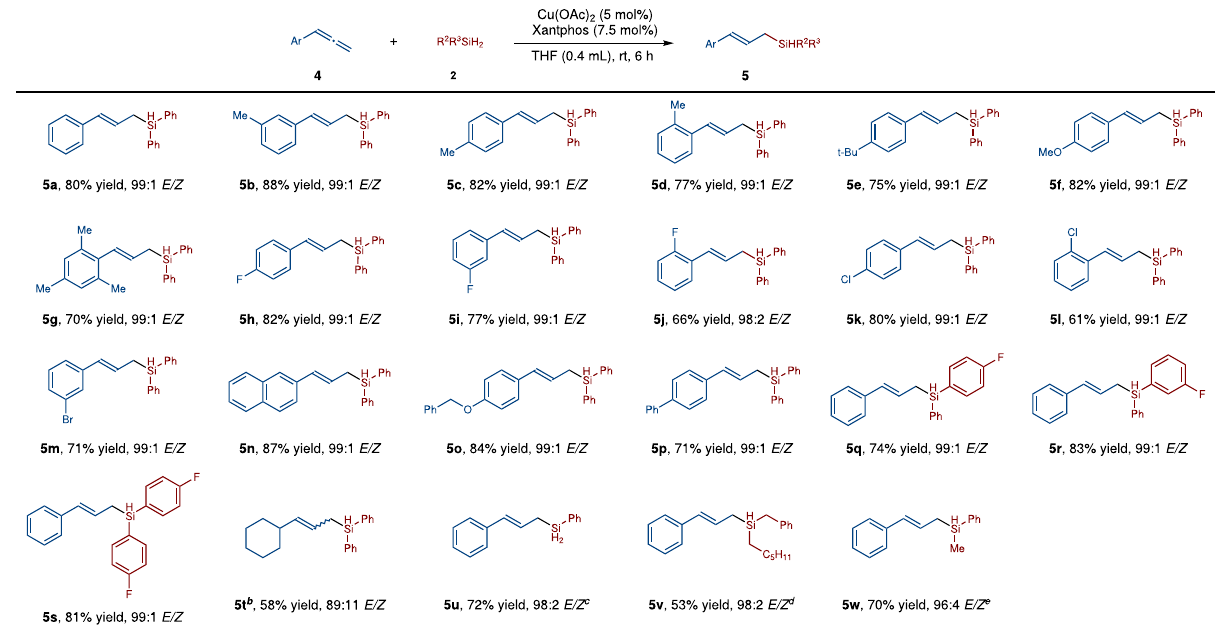
Fig. 3 Scope of monosubstituted allenes. Otherwise noted, the reaction was performed under the following conditions: a allene (0.20 mmol), R 2 R 3 SiH 2 (0.22 mmol), Cu(OAc) 2 (0.01 mmol, 5 mol%), Xantphos (0.015 mmol, 7.5 mol%), THF (0.4 mL), rt, 6 h; the yield refers to the isolated yield; Z / E ratio was determined by GC-MS or HNMR analysis of the unpuri fi ed reaction mixtures b . Allene (0.40 mmol), Ph 2 SiH 2 (0.2 mmol),The yield of 5t was determined by HNMR c . Allene (0.20 mmol), PhSiH 3 (0.4 mmol), Cu(OAc) 2 (0.005 mmol, 2.5 mol%), Xantphos (0.0075 mmol, 3.75 mol%), THF (0.4 mL), rt, 30 min d .